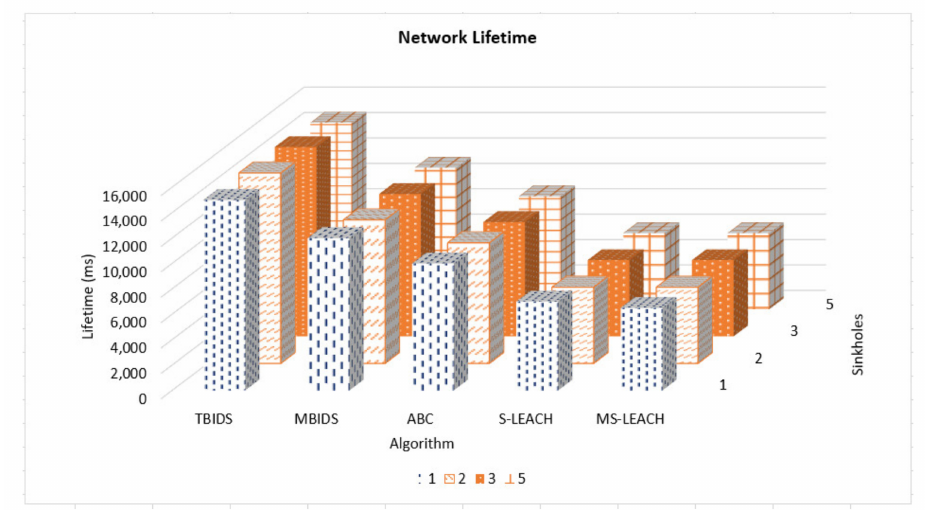
Figure 15. Lifetime for small-scale networks.